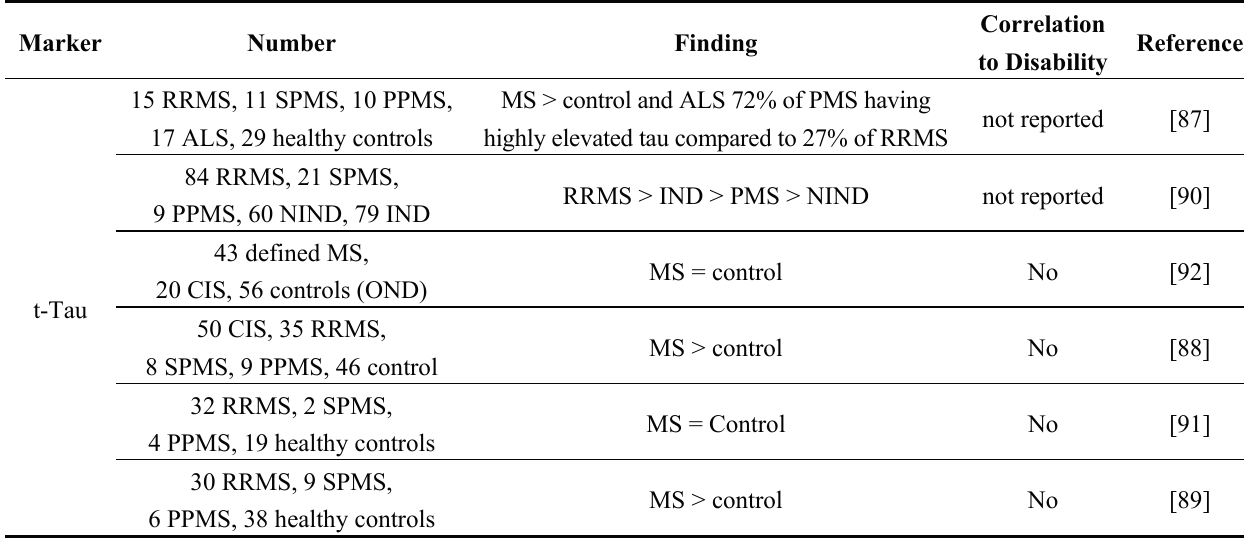
Table 4. CSF levels of total Tau-protein (t-Tau) in primary progressive multiple sclerosis (PPMS) as compared to healthy controls, relapsing remitting (RRMS) and secondary progressive multiple sclerosis (SPMS) and other inflammatory- and non-inflammatory neurological